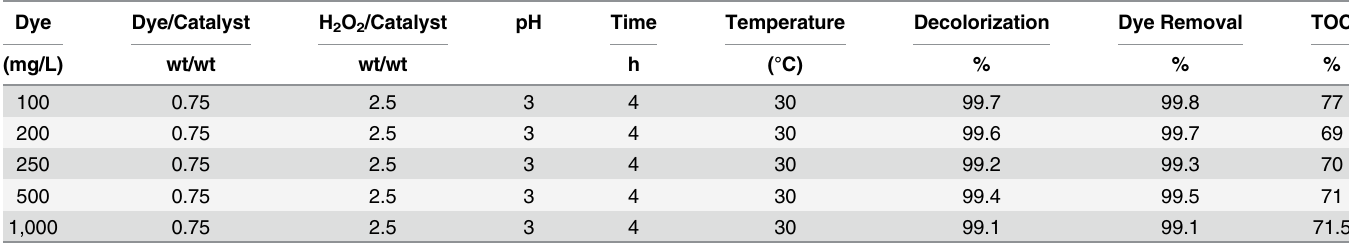
Table 11. Optimized values for heterogeneous Fenton oxidation. Dye Dye/Catalyst